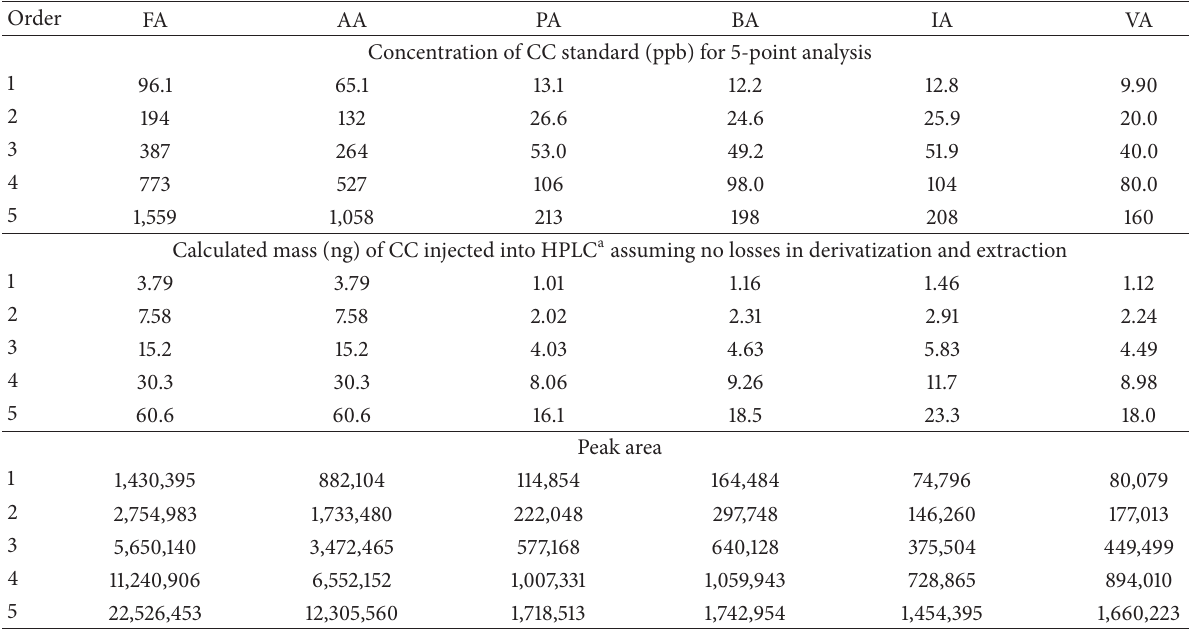
Table 2: Comparison of HPLC-based calibration analysis of CC between gas- and liquid-phase